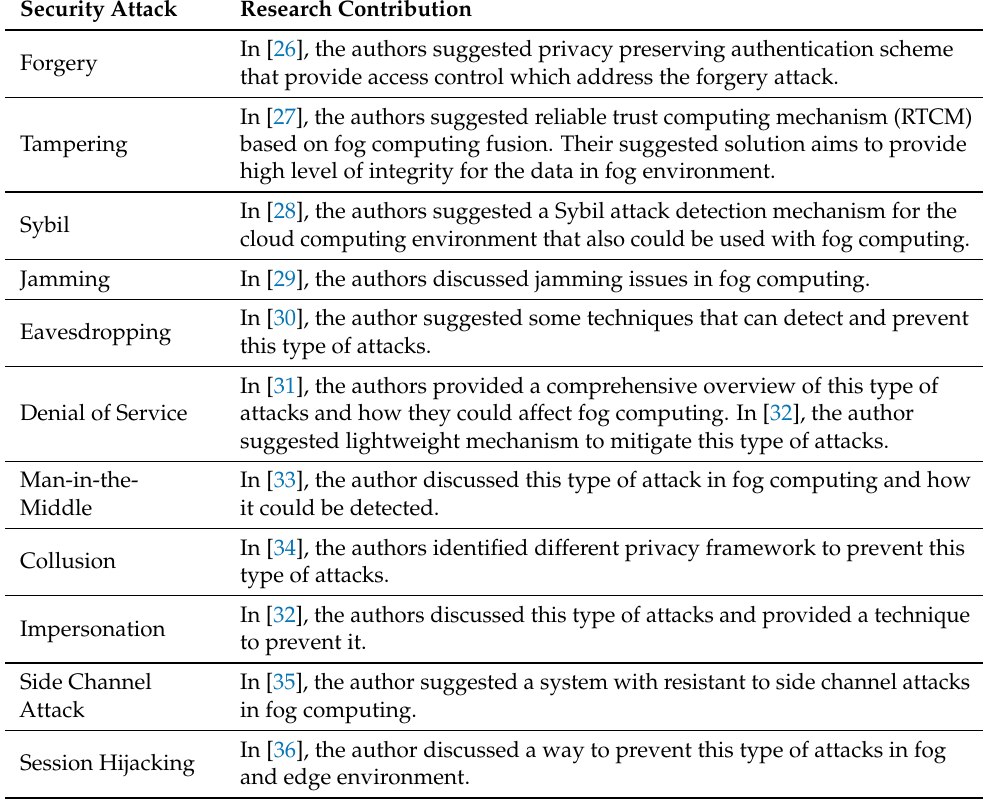
Table 1. security attack in fog computing with some researches